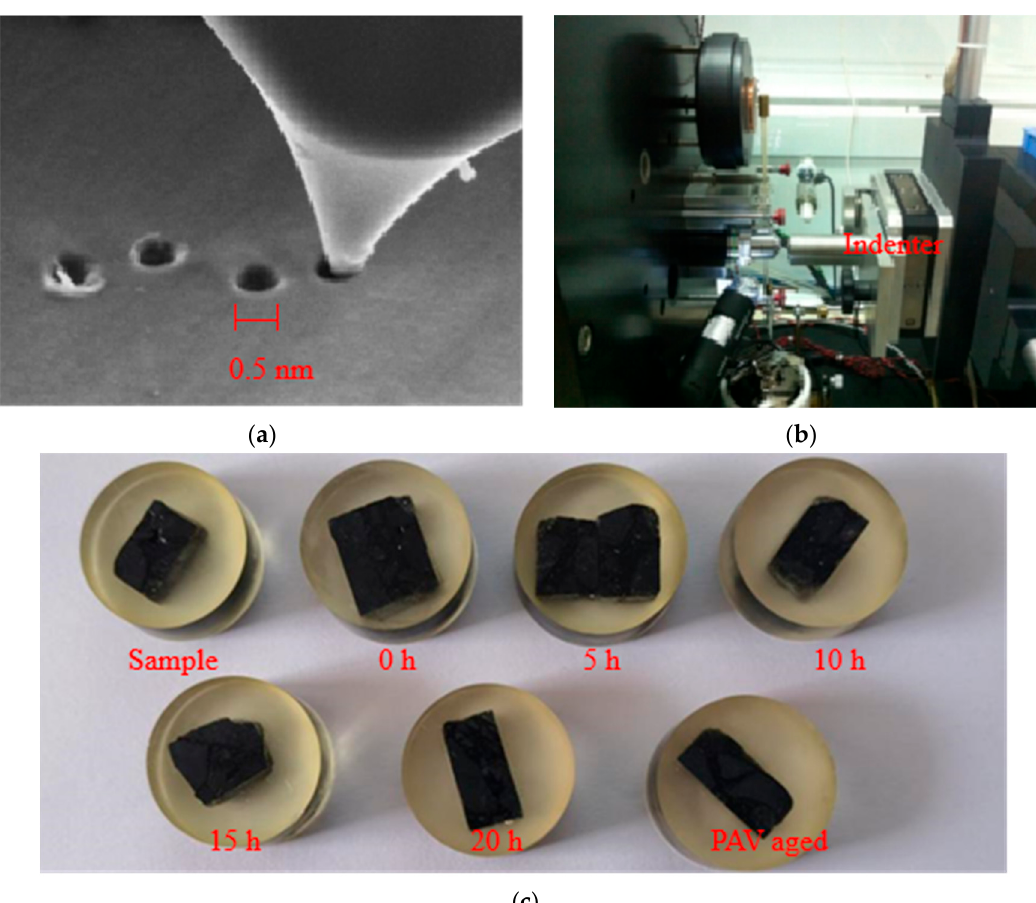
Figure 2. Photographical illustration of the nano-indentation test procedure: ( a ) the scale of experiment; ( b ) nano-indentation test equipment; ( c ) test samples under different aged time.